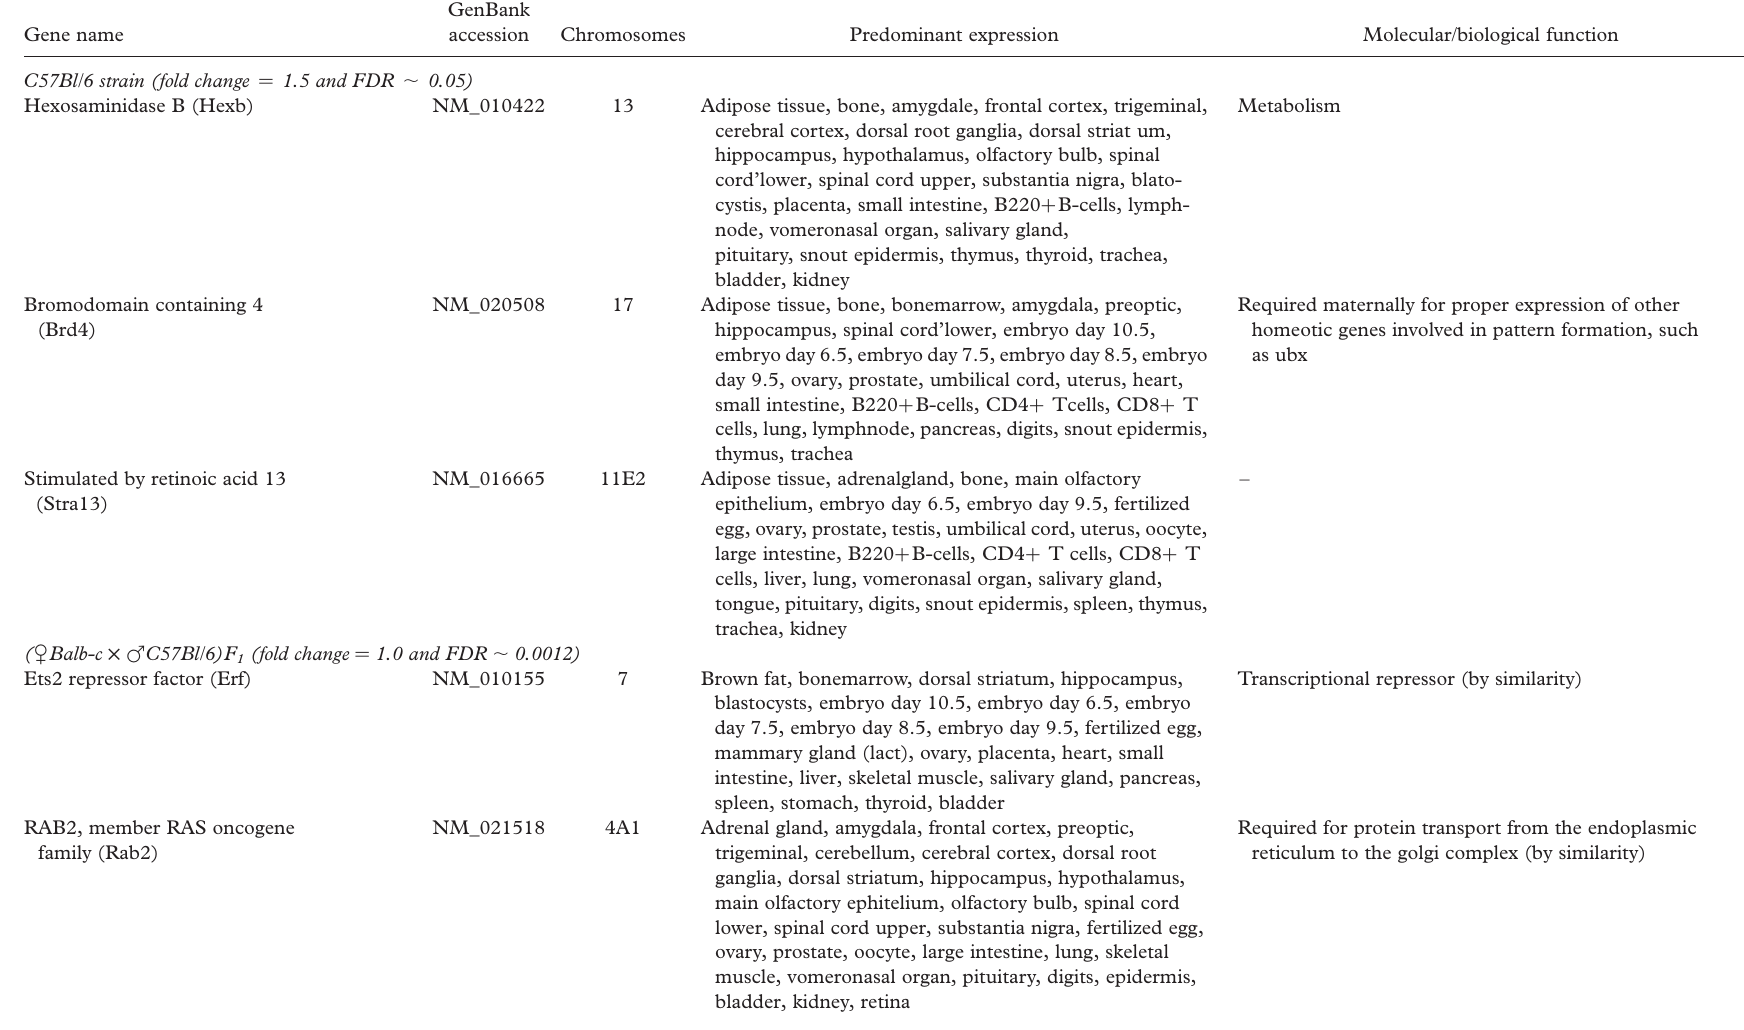
Table I. Genes differentially and significantly induced in the thymus of C57Bl/6 and ( C Balb-c £ F C57Bl/6)F 1 as detected by the SAM program. Fold change $ 1 and FDR, false discovery rate. Magalha˜es et al. (2006) promiscuous gene expression in the